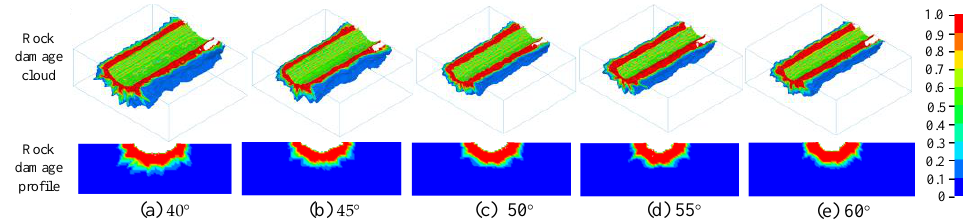
Figure 9. The cutting force curves of conical pick with different cutting angles. The cutting force curves show that the fluctuation and variation laws are different under different cutting angles. As the cutting angle increases, the fluctuation in the cutting force decreases gradually, the cutting process is stable, and the maximum peak force of the conical pick also decreases gradually. Because the interaction area between the conical pick and rock increases gradually with the cutting angle, the rock breaking volume with various cutting angles is different, resulting in different fluctuations in the conical pick force. Additionally, the cutting angles greatly affect rock damage, and the rock damage cloud with different cutting angles is shown in Figure 10. The volume of rock damage is greatly impacted by the cutting angle. The thickness of the rock damage with different cutting angles is basically the same, but the notch size of the rock damage is changed; therefore, as the cutting angle increases, the rock damage decreases.